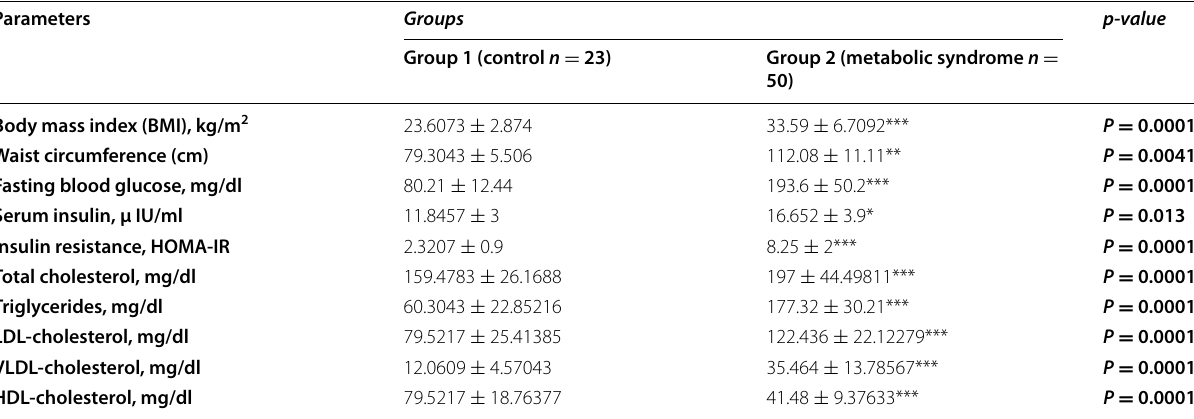
Table 1 Mean SD of different parameters in the studied groups ±